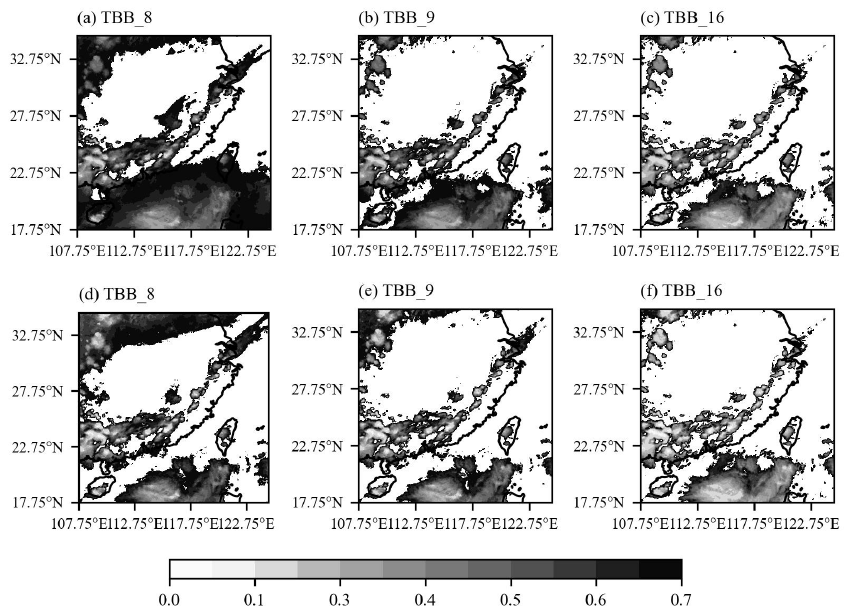
Figure 9. Comparisons between Area-based normalization ( a – c ) and Pixel-based normalization ( d – f ) at 0930 UTC 21 August